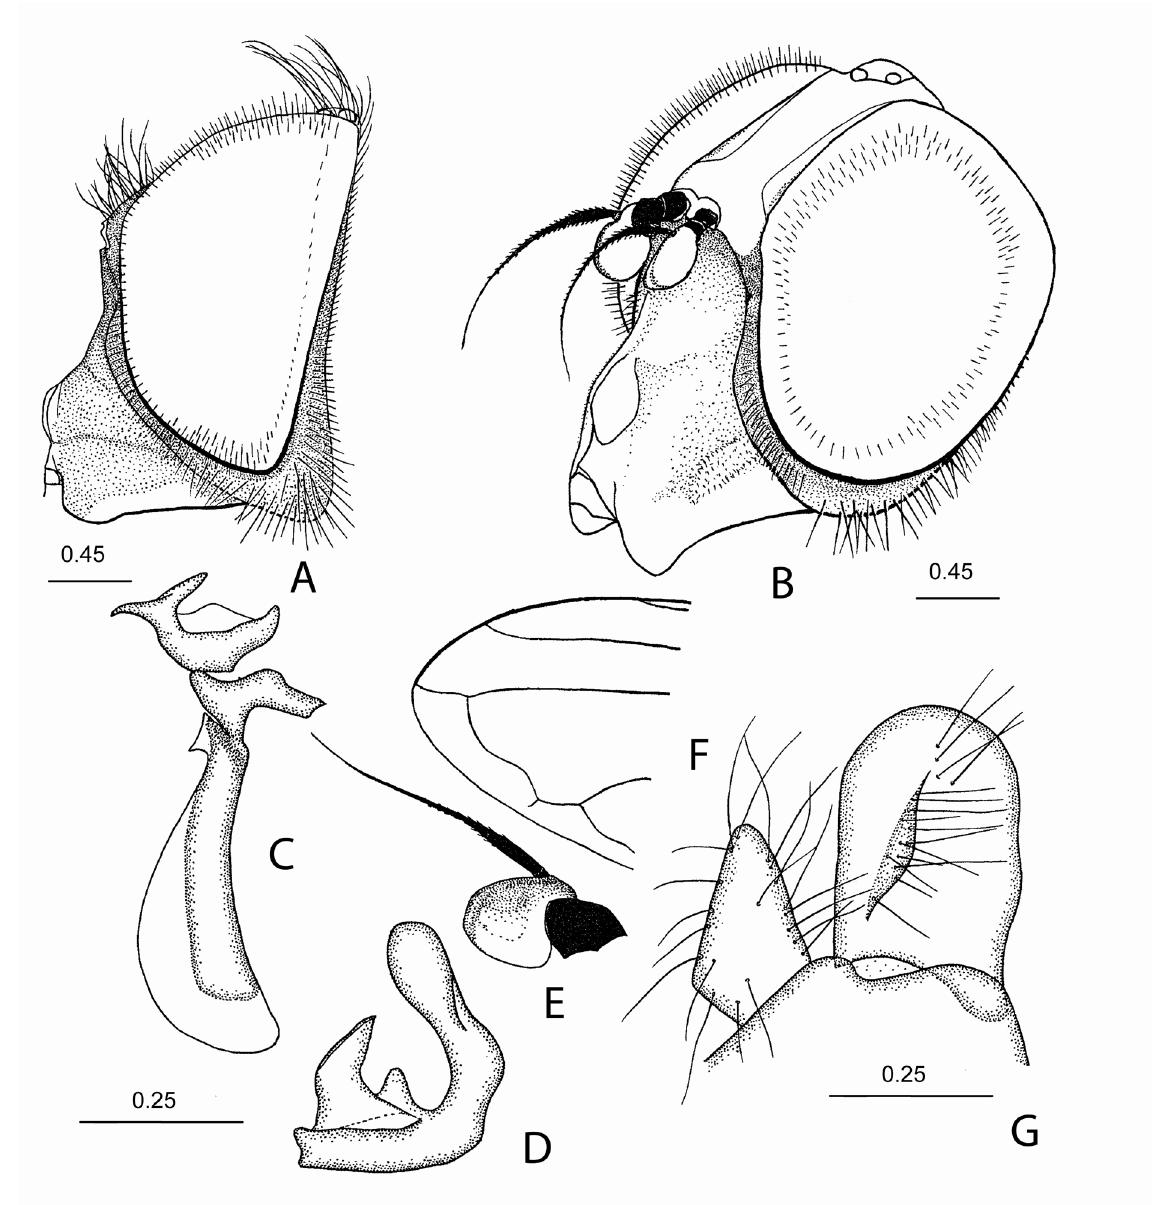
Fig. 62. Cheilosia ( Cheilosia ) suspecta Barkalov & Cheng, 2004. A . Male head, lateral view. B . Female head, anterior view. C . Aedeagus and aedeagal apodeme, lateral view. D . Superior lobe of hypandrium, lateral view. E . Basoflagellomere, lateral view. F . Tip of wing. G . Surstylus and gonocercus, lateral view. After Barkalov & Cheng 2004. Scale bars indicated in